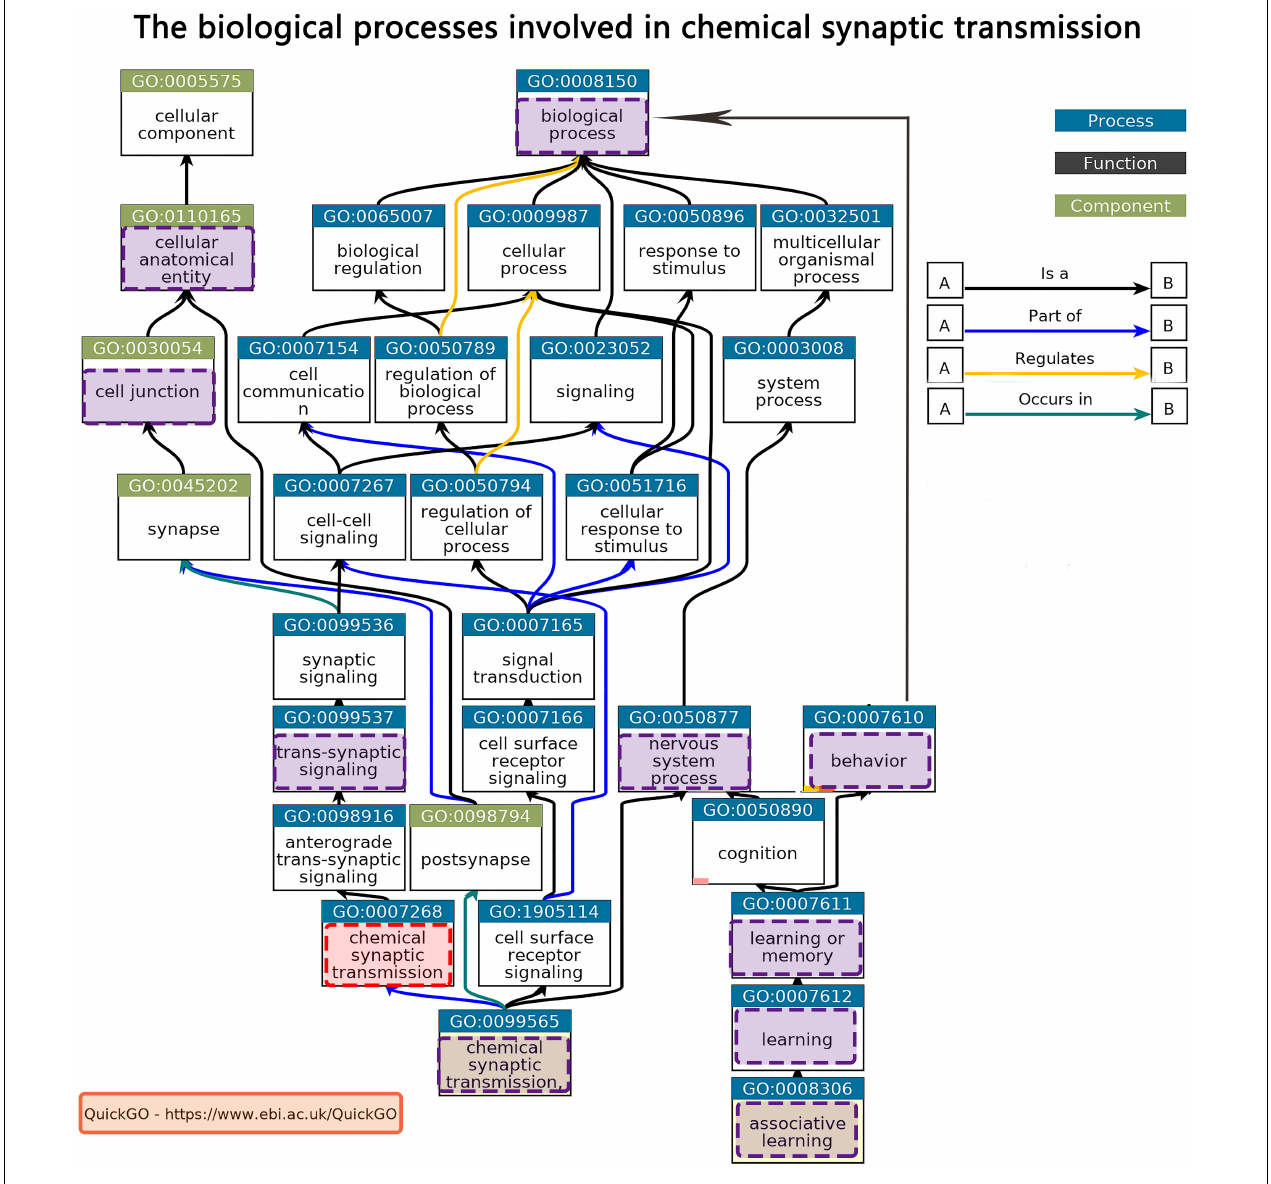
FIGURE 5 | Biological processes involved in chemical synaptic transmission from